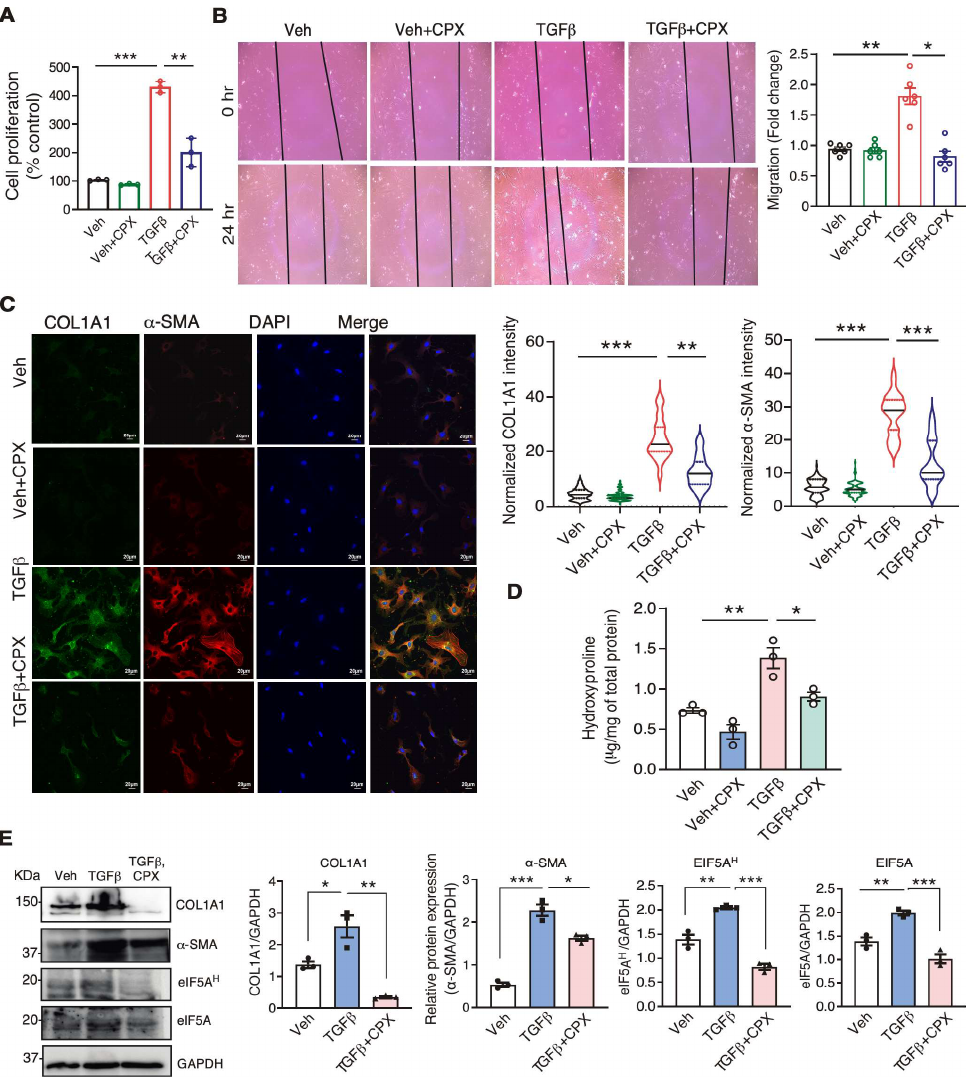
Figure 5. Ciclopirox inhibits cardiac fibroblast activation, migration, and ECM protein expression. ( A ) The cell proliferation rate of Veh., CPX, TGF β , TGF β + CPX treated primary mouse CFs. ( B ) Representative images of migrating cells of the vehicle and CPX-treated primary mouse CFs after vehicle or TGF β treatment. Quantification of scratch closure after 24 h was shown. n = 6 for each group, and each experiment was repeated 3 times. ( C ) IF quantification of COL1A1 and α -SMA protein expression after CPX treatment in TGF β -treated primary mouse CFs. n = 120–150 cells from three biological replicates were analyzed. Scale bar: 20 μM. Representative images were shown. ( D ) Measurement of hydroxyl-proline in the vehicle and CPX-treated primary mouse CFs after vehicle or TGF β treatment. n = 3 for all the groups. ( E ) Western blot measurement of protein expression of COL1A1, α -SMA, hypusinated eIF5A, and eIF5A in the vehicle and CPX-treated primary mouse CFs after vehicle or TGF β treatment. Quantification of protein expression level was shown. n = 3 for each group. * p < 0.05, ** p < 0.01, *** p < 0.001 by Two-way ANOVA with Tukey’s multiple comparisons